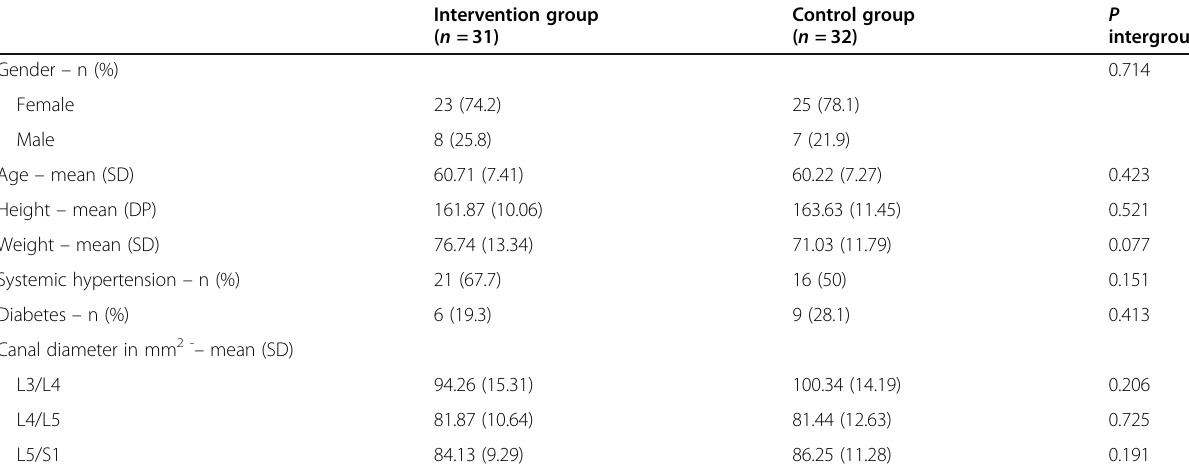
Table 1 Demographic data of sample cohorts at baseline